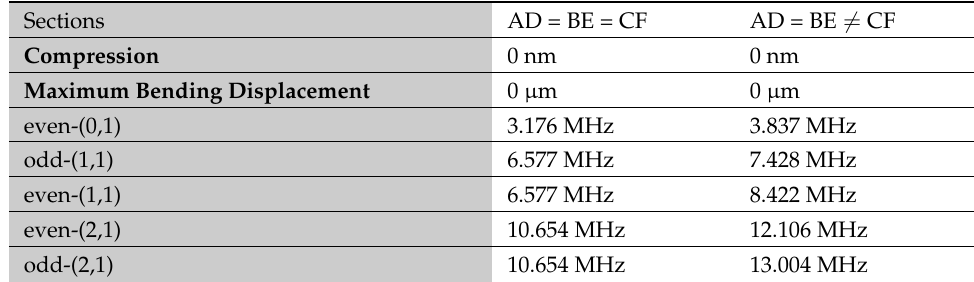
Table 1. The first five resonant frequencies for the cases where AD = BE = CF amd AD = BE (cid:54) = CF. The different mode shapes can be seen in Figure